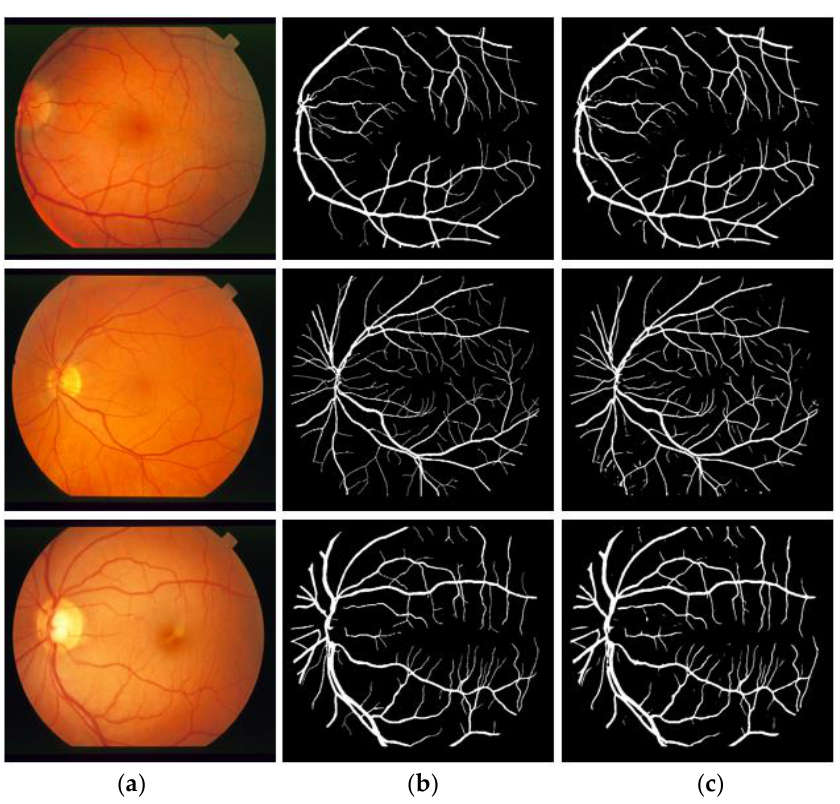
Figure 8. VSUL-Net visual results for the CHASE-DB1 dataset: ( a ) original fundus image, ( b ) expert annotation, and ( c ) VSUL-Net predicted mask.